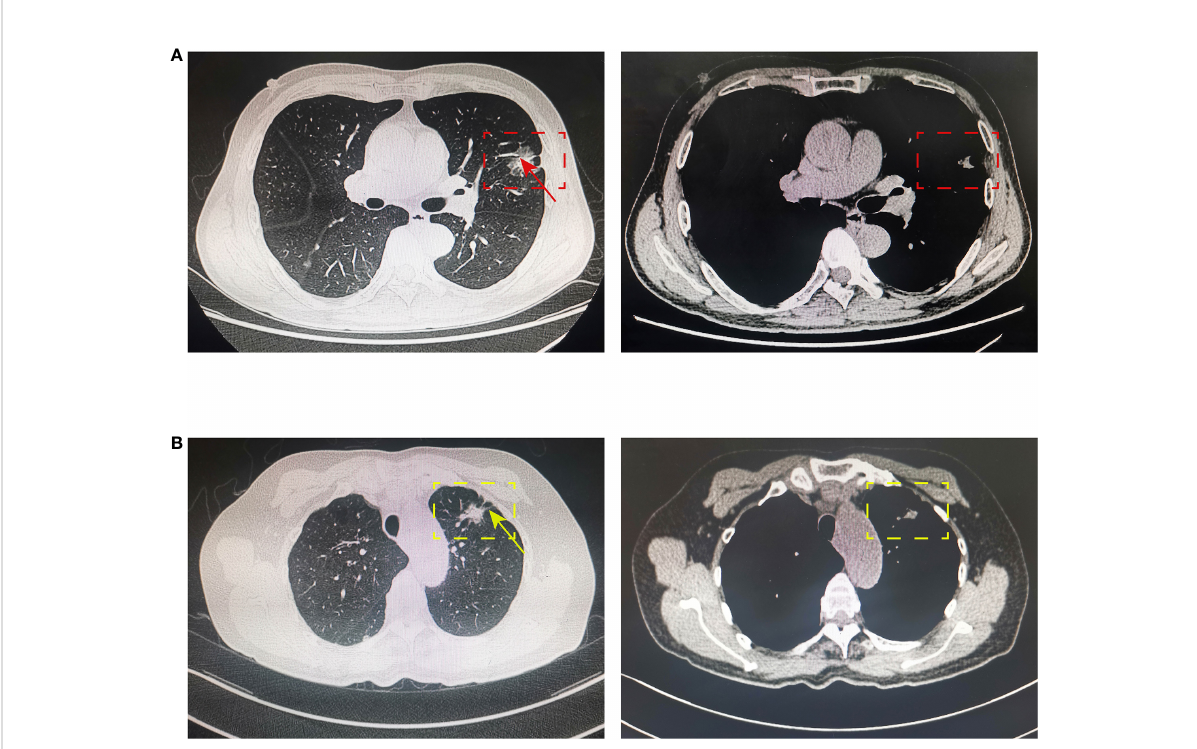
FIGURE 2 Bronchial cutoff and spiculation sign on CT. (A) The bronchial cutoff sign of PSILA is shown in the pulmonary window (left) and mediastinal window (right). The red box shows the location of the tumor, and the red arrow shows the classical bronchial cutoff sign. (B) The spiculation sign of PSILA is shown in the pulmonary window (left) and mediastinal window (right). The yellow box shows the location of the tumor, and the yellow arrow shows the classical spiculation sign. .